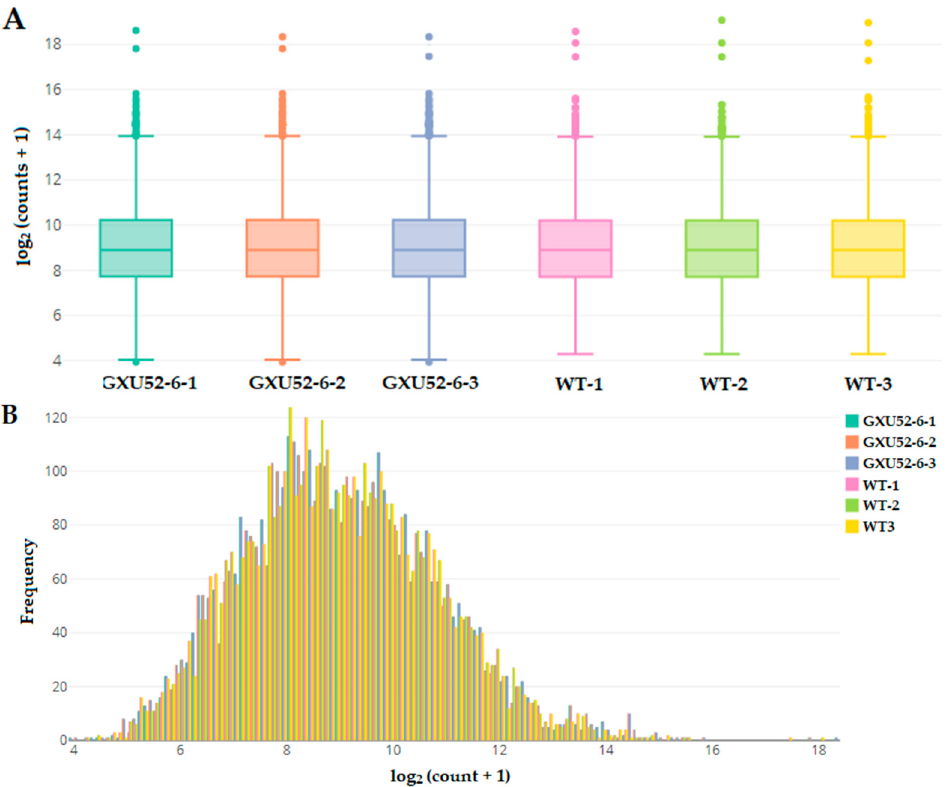
Figure 4. Basic information about proteomic analysis of the wild type (WT) and mutant line (GXU52-6). ( A ) Box-and-whisker plot of proteomic count data distribution with log2 values of the normalized abundance; ( B ) Histogram for count data distribution frequency of transformed data from WT and mutant line.